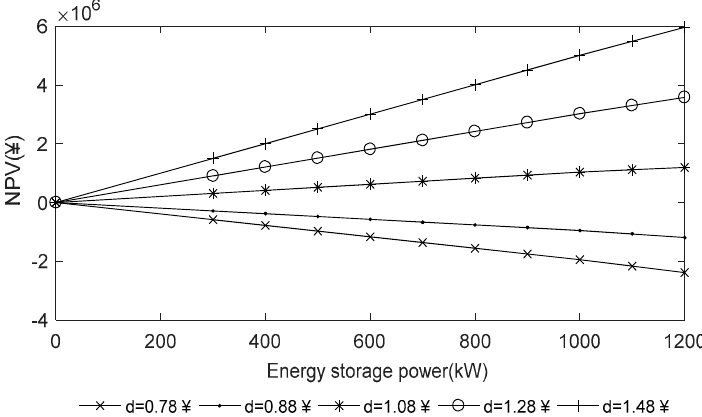
Figure 12. Economics of users participating in load peak shaving service under different energy storage costs.